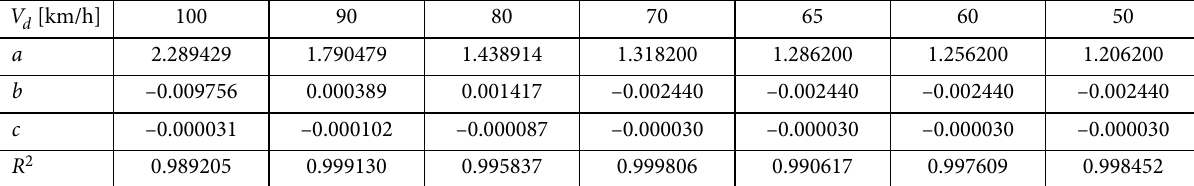
Table 2. Regression coefficients for determining the correction factor of fuel